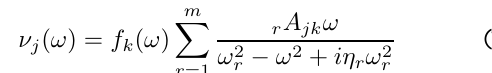
Fig. 1. Vibration response of a structure (in one mode of vibration) to an impact, Measured (a) at a fixed point, (b) using a scanning laser Doppler vibrometer. hysteretic